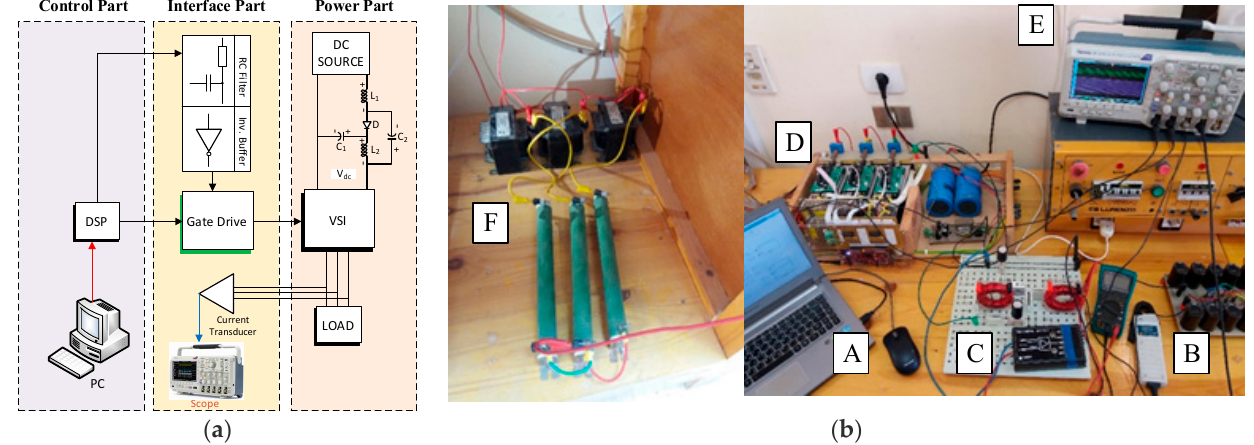
Figure 26. Experimental prototype. (a) Block diagram and (b) system photographs. Table 7. QZSI Experimental setup parameters. Parameter